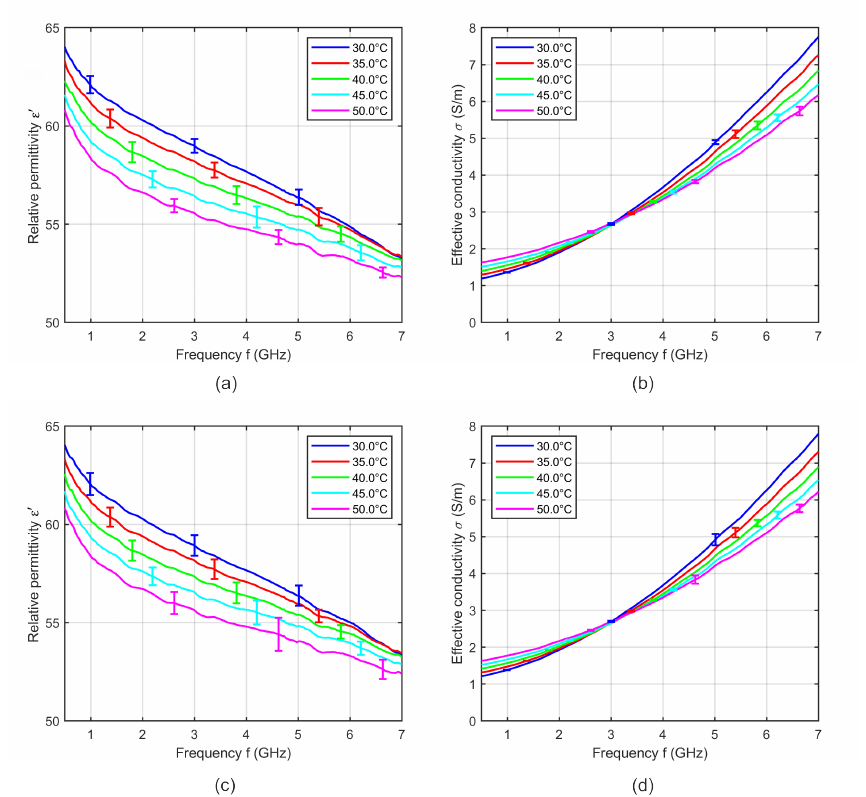
Figure 6. Mean relative permittivity and mean effective conductivity of three porcine blood samples acquired during ( a , b ) heating and ( c , d ) cooling cycle as a function of frequency at different temperatures. Error bars indicate the corresponding standard deviation.